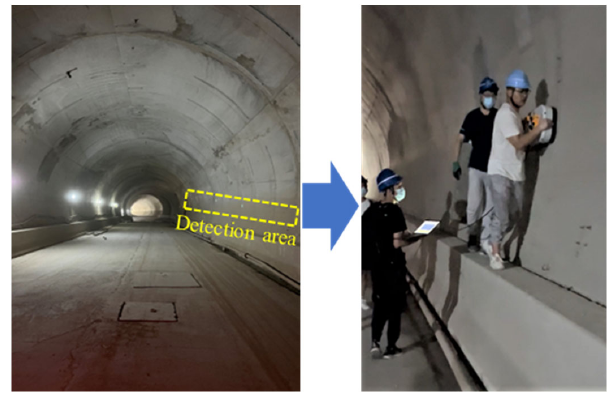
Figure 5. On ‐ site data acquisition of GPR in a mountain tunnel.